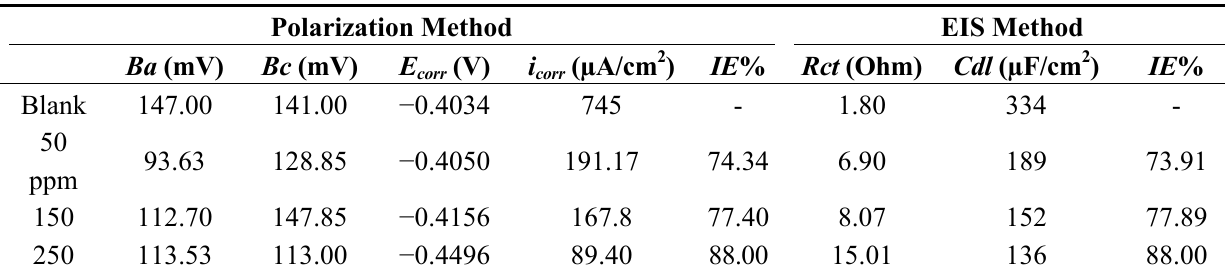
Table 2. Inhibition efficiency values for steel in 1 M HCl with different concentrations of inhibitor calculated by Polarization and Electrochemical Impedance Spectroscopy (EIS) methods at 25